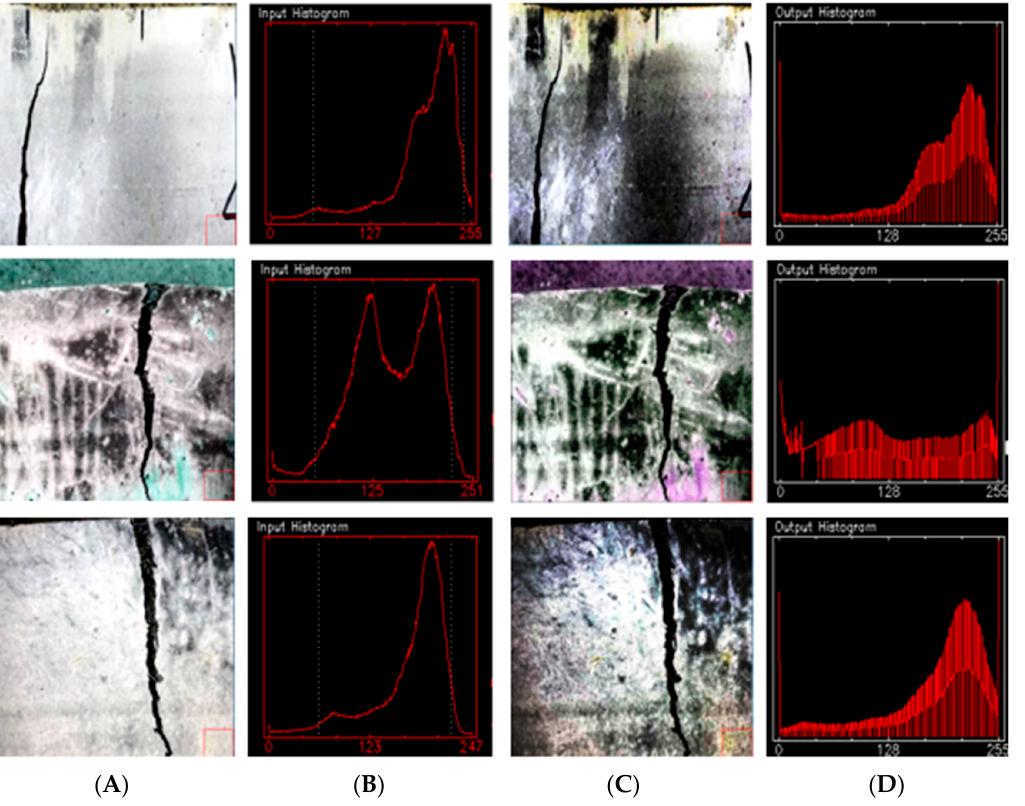
Figure 5. Histogram comparison. ( A ) Original image; ( B ) original histogram; ( C ) equalization images; ( D ) equalization histogram.